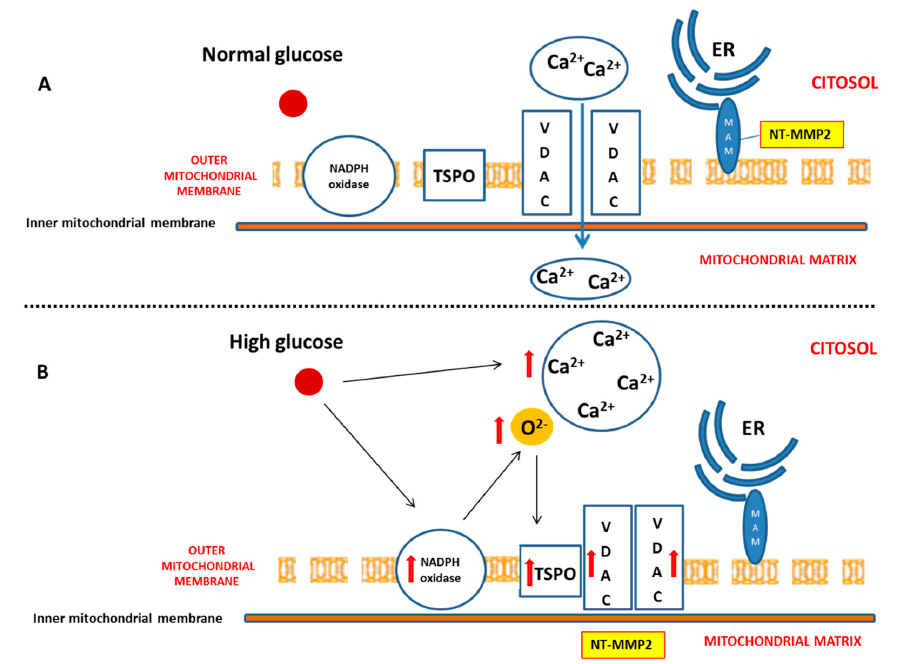
Figure 7. Effect of hyperglycaemia on cardiomyocyte. ( A ) Under physiologic glucose levels, VDAC1 Figure 7. E ff ect of hyperglycaemia on cardiomyocyte. ( A ) Under physiologic glucose levels,